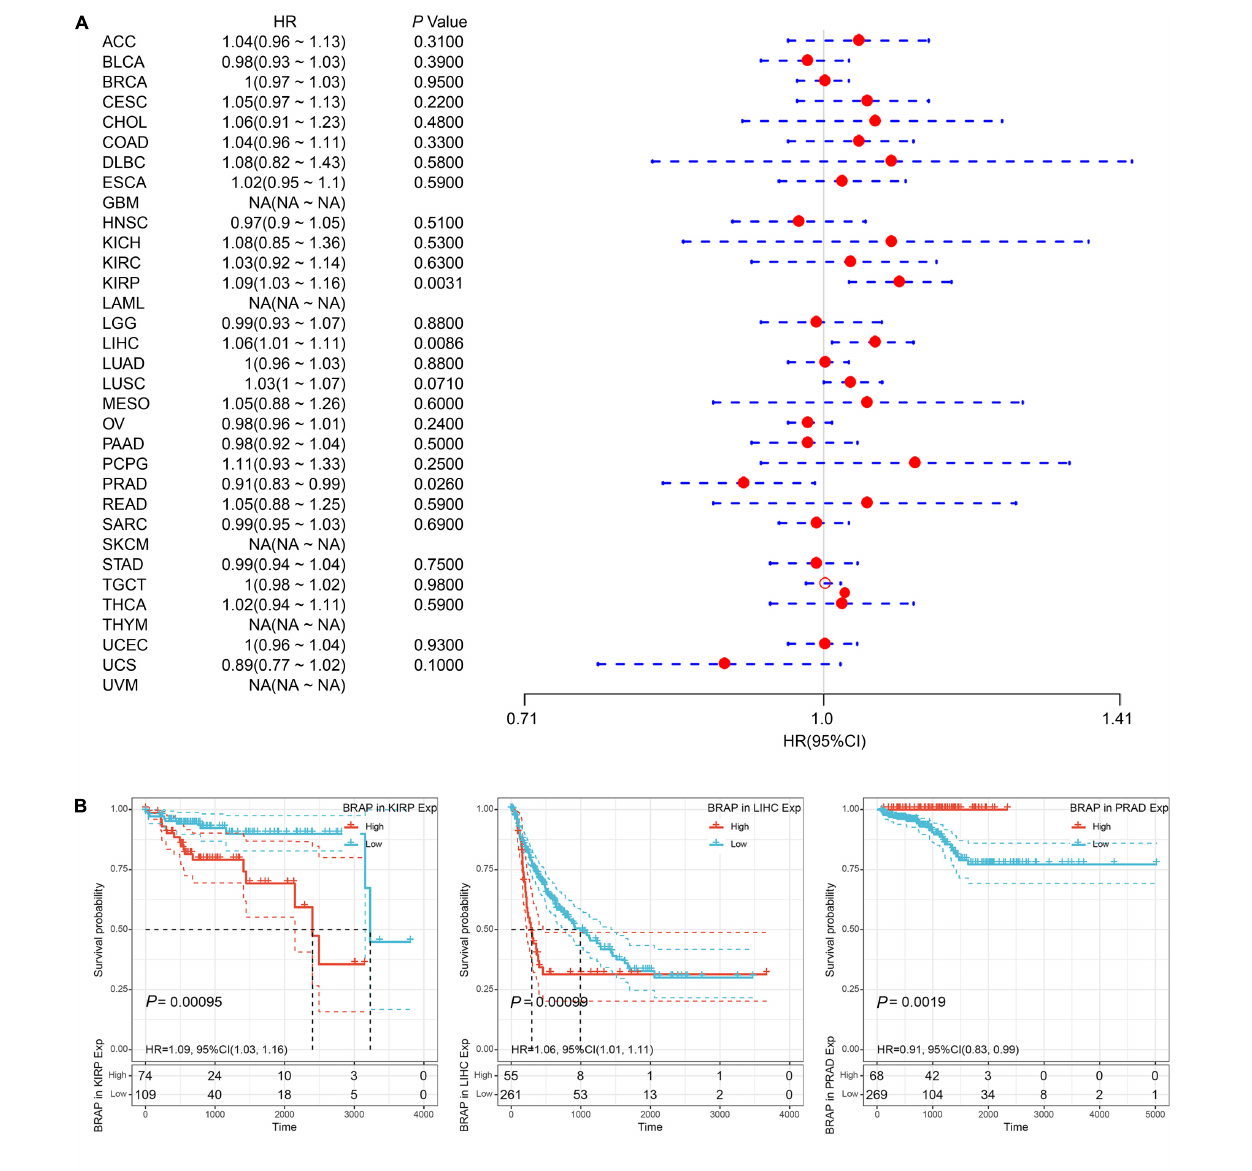
PCAWG Transcriptome Core Group, Calabrese et al.,